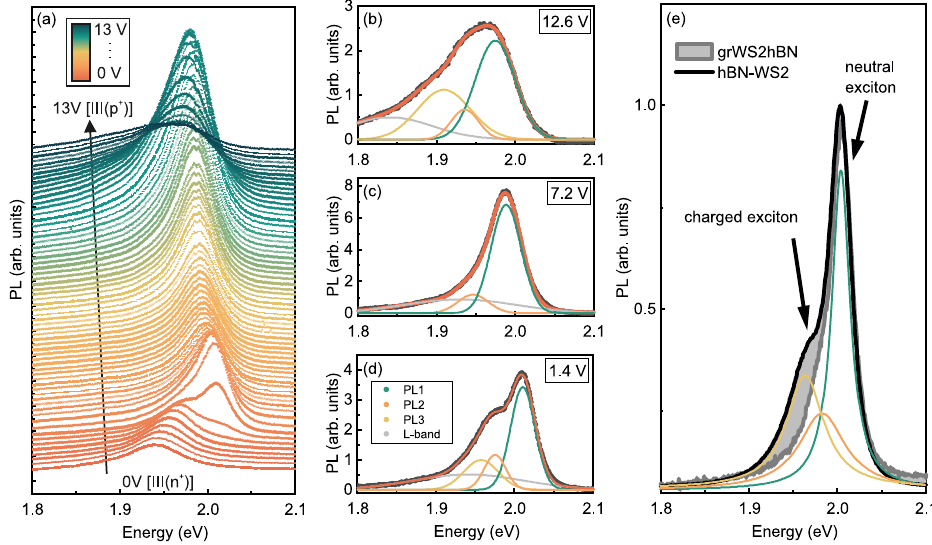
Figure 2. ( a ) Water Fall representation of individual spectra for a gate voltage sweep from 0 V to 13 V clearly displaying changes in intensity and lineshape. ( b – d ) Line-shape analysis using a sum of 3 or 4 Gaussian reproducing the spectra for gate voltages of 12.6 V [II( p )] ( b ), for 7.2 V [I] ( c ) and of 1.4 V. [III( n + )] ( d ). Emission line PL3 is absent in the intrinsic regime. PL4 is assigned to defect related emission. ( e ) PL spectra for a WS 2 ML encapsulated in hBN (green trace) and in hBN and few-layer graphene (red trace). The graphene layer drains free charge carriers such that only charge-neutral excitons contribute to the emission. The spectra reproduced by 2 or 3 Gaussians such that PL3 is assigned to trion and PL4 to defect emission (absent in encapsulated WS 2 ). [ T = 300 K, λ Laser = 532 nm; P = 50 µ